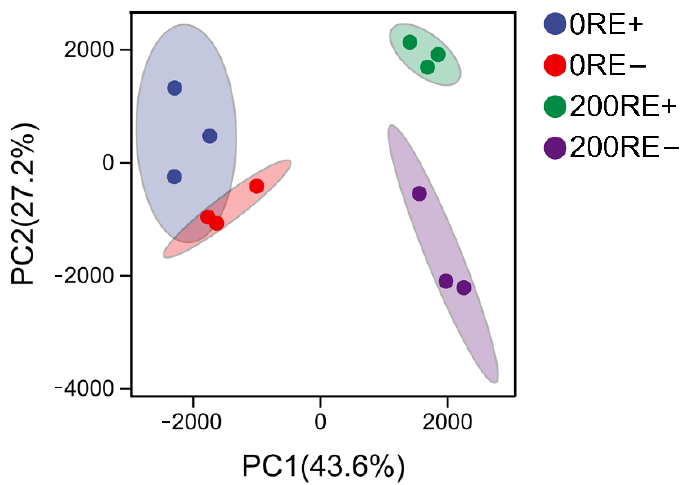
Figure 1. Principal component analysis (PCA) score plot showing the differences of transcriptome in roots between E. gansuensis -infected (E+) and E. gansuensis -free (E − ) A. inebrians under 0 and 200 mM NaCl concentrations. 0RE+/ − : roots of A.inebrians with or without E. gansuensis at 0 mM NaCl; 200RE+/ − : roots of A.inebrians with or without E. gansuensis at 200 mM NaCl.